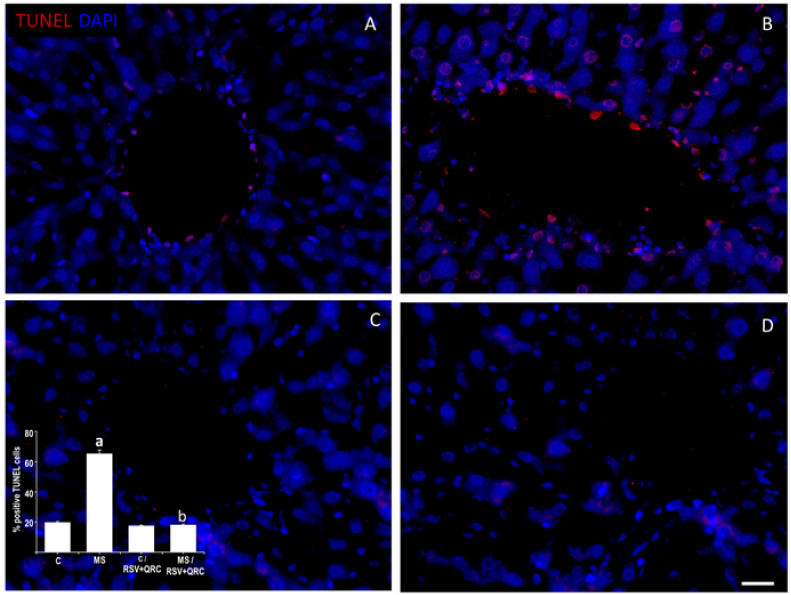
Figure 6. Resveratrol and quercetin treatment decreased apoptosis in livers from MS rats. The cells in apoptosis are located towards the lumen of the vessels as well as in the hepatocytes around the vessels, mainly in the central vein. The nuclei were marked with DAPI. The graph with the percentage of positive TUNEL positive cells is in the lower-left corner. a p < 0.05 vs. Control; b p < 0.01 vs. MS group. Panel ( A ) = Control group, Panel ( B ) = metabolic syndrome (MS) group, Panel ( C ) = Control/RSV + QRC group, Panel ( D ) = MS/RSV + QRC group. Bar = 50 µ